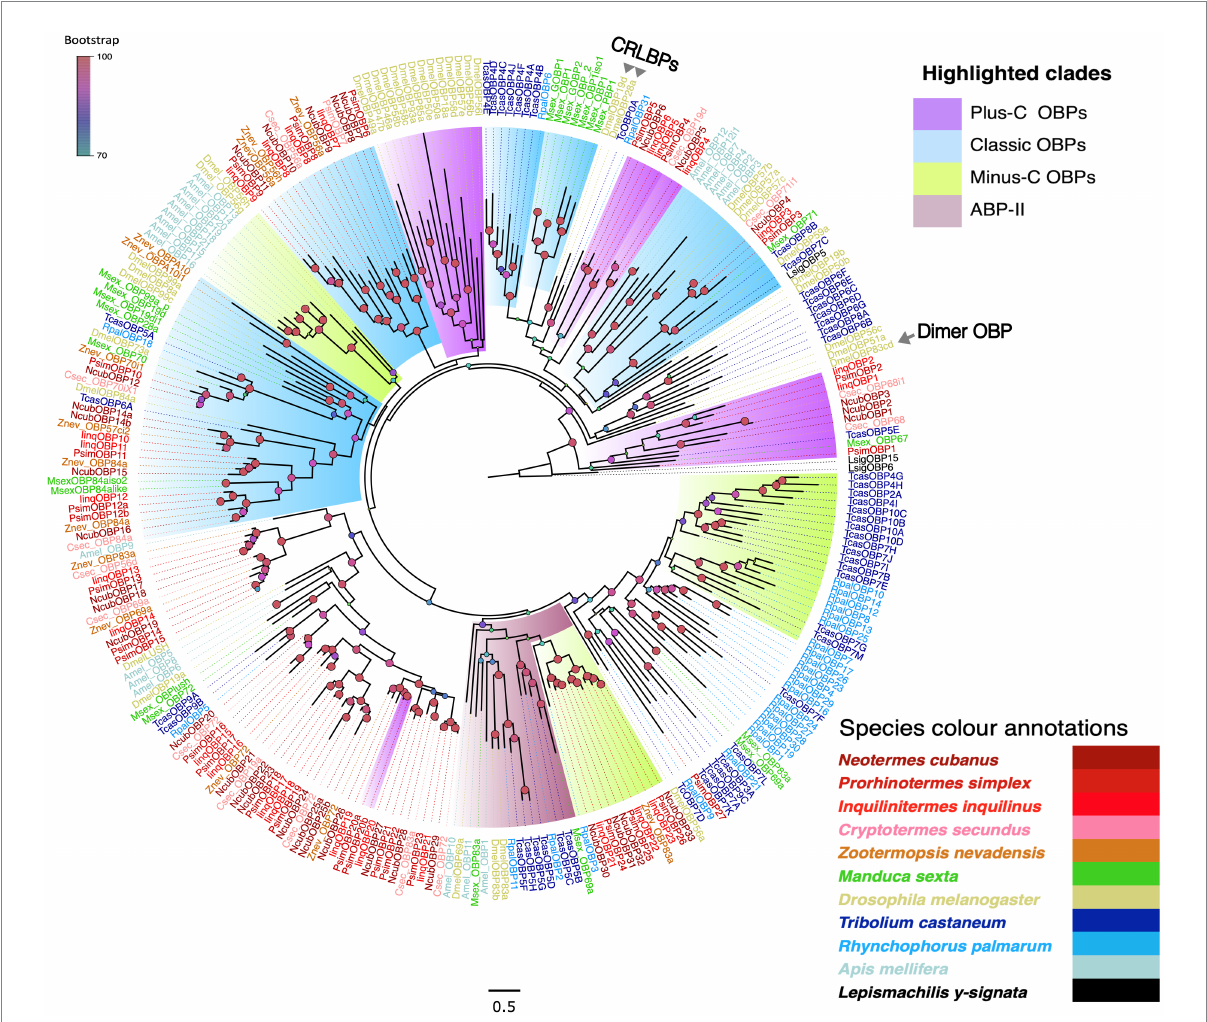
FIGURE 5 Maximum likelihood phylogeny of termite OBPs. The tree was constructed using LG + R as the best-fit amino acid substitution model and using L. y-signata OBPs as outgroup. The major OBP groups are highlighted as Classic OBPs (blue), Minus-C (green), Plus-C (violet) and ABP-II (maroon); due to low representation Dimer OBPs (DmelOBP83c) and CRLBPs (DmelOBP19D and DmelOBP28a) reported from D. melanogaster are not highlighted, but labelled. Sequence names are colored according to species and color codes are provided in the in-figure legend. The species included are C. secundus (Csec), N. cubanus (Ncub), P. simplex (Psim), I. inquilinus (Iinq), Z. nevadensis (Znev), D. melanogaster (Dmel), T. castaneum (Tcas), R. palmarum (Rpal), M. sexta (Msex), Apis mellifera (Amel) and L. y-signata (Lsig). The node colors indicate bootstrap support and the scale bar represents estimated amino acid substitutions per